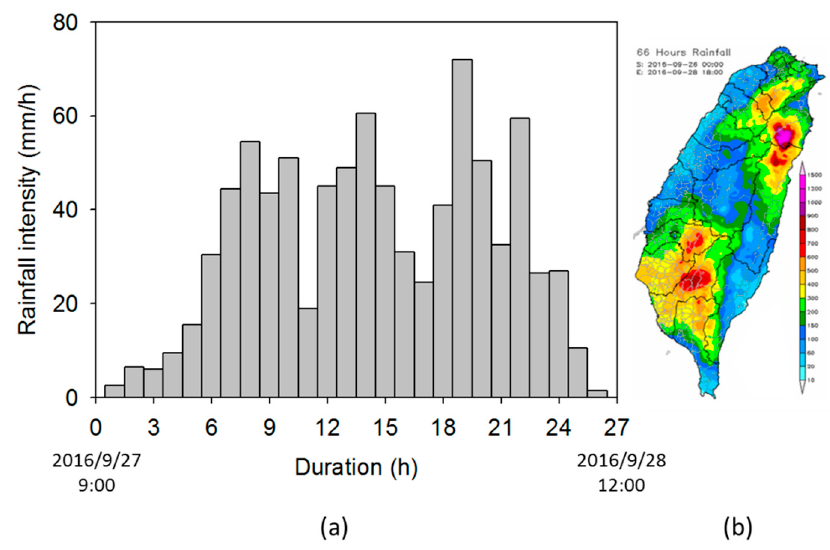
Figure 6. Meteorological data of Typhoon Meigi: ( a ) Hyetograph in the study area; ( b ) spatial distribution of accumulated rainfall amount (Source: National Science and Technology Center for Disaster Reduction, Taiwan).